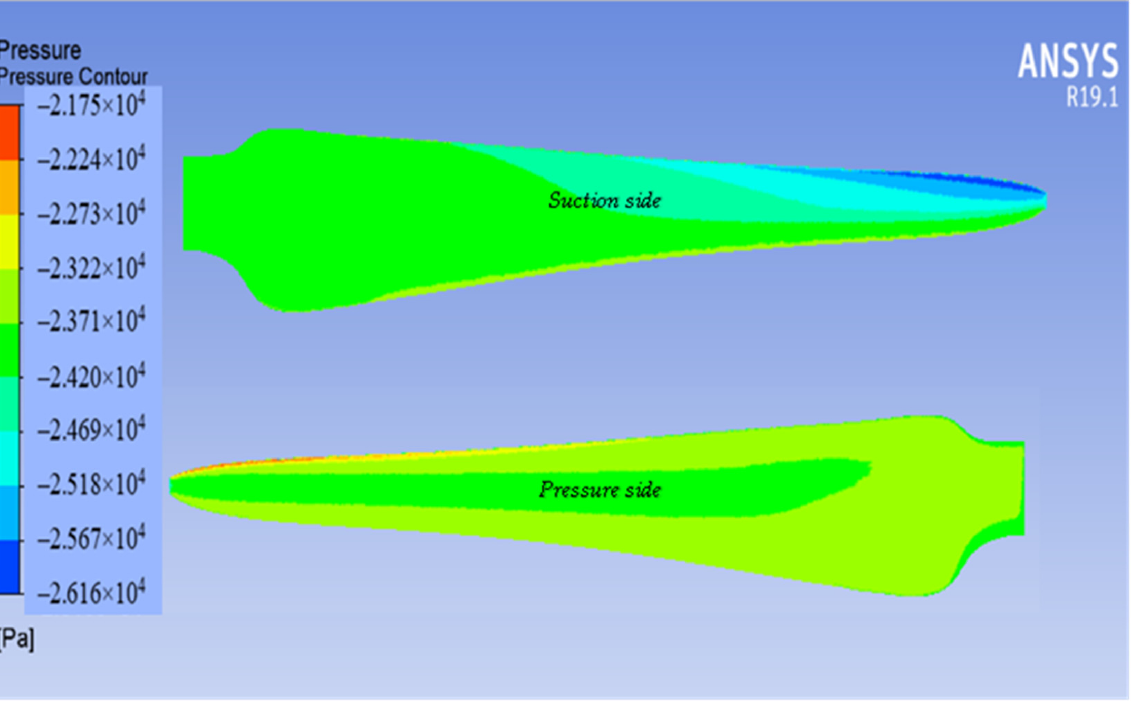
Figure 10. Pressure contour at design conditions of the blade surface for the suction and pressure sides.